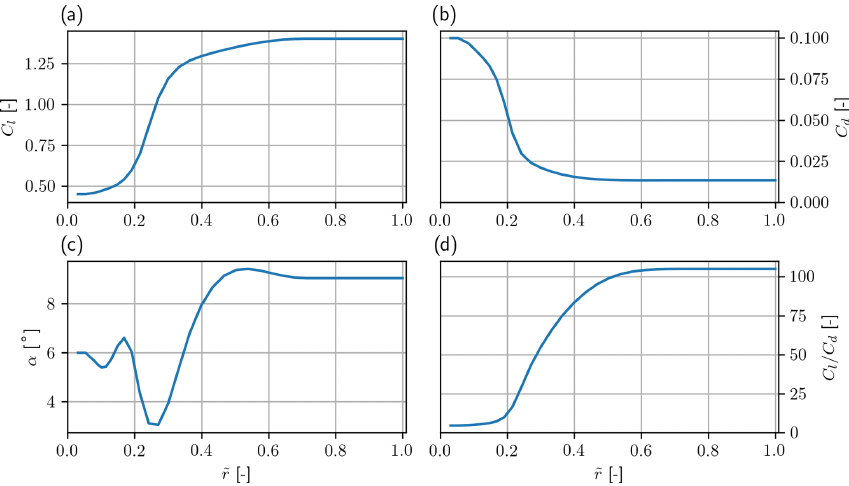
Figure 6. Aerodynamic input based on the polars from the 10MW DTU reference turbine. (a) Lift coefficient ( C l ), (b) drag coefficient ( C d ),